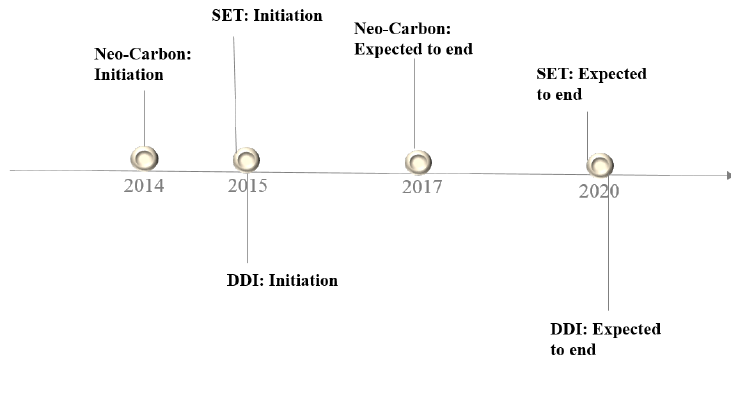
Fig. 2. Timeline of the three